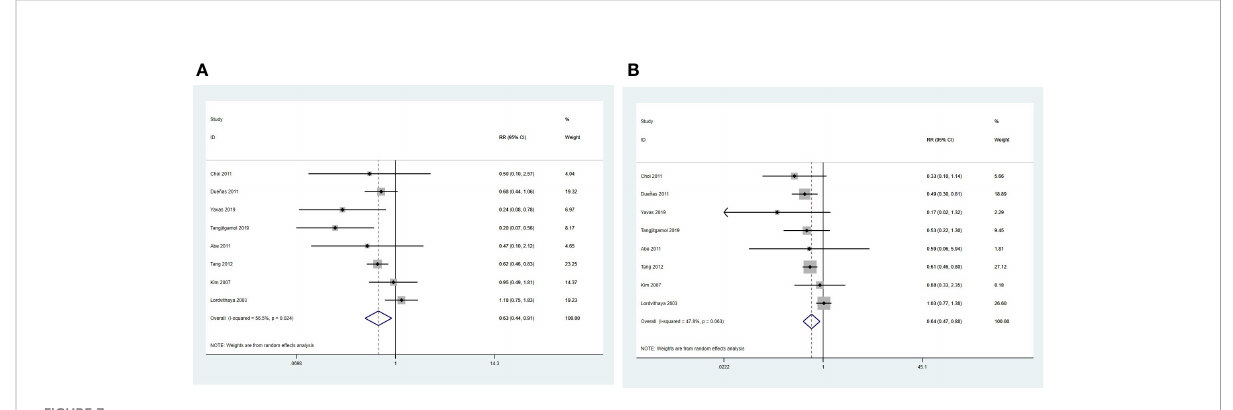
FIGURE 7 Forest plot of total failure: (A) local recurrences; (B) distant